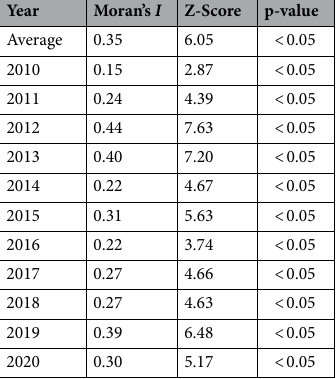
Table 2. Yearly spatial autocorrelation analysis on scrub typhus incidence in Anhui, China,